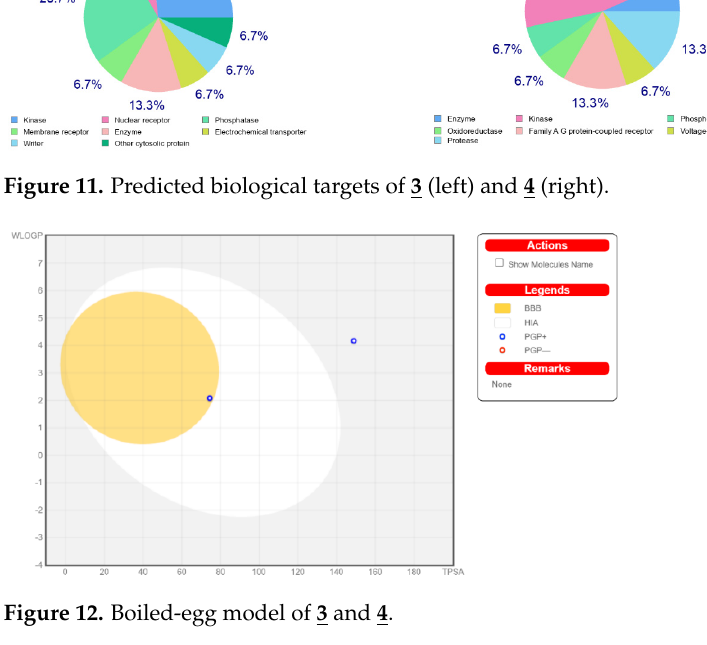
Figure 12. Boiled-egg model of 3 and 4 .